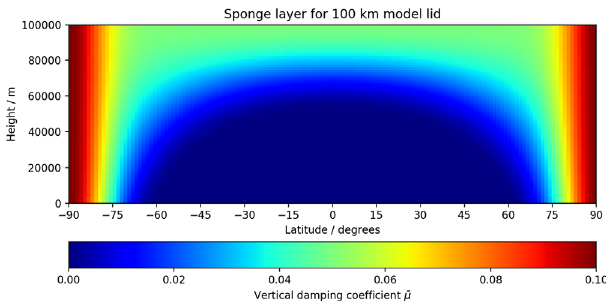
Fig. 1. The default sponge layer with vertical damping coef fi cient (cid:3) l ¼ 0 : 05 s (cid:4) 1 and 100 km model lid. The sponge layer can be seen to be at (cid:3) l ¼ 0 : 05 s (cid:4) 1 for most latitudes and for high altitudes but is doubled at the polar latitudes for all altitudes to help numerical stability in this area.